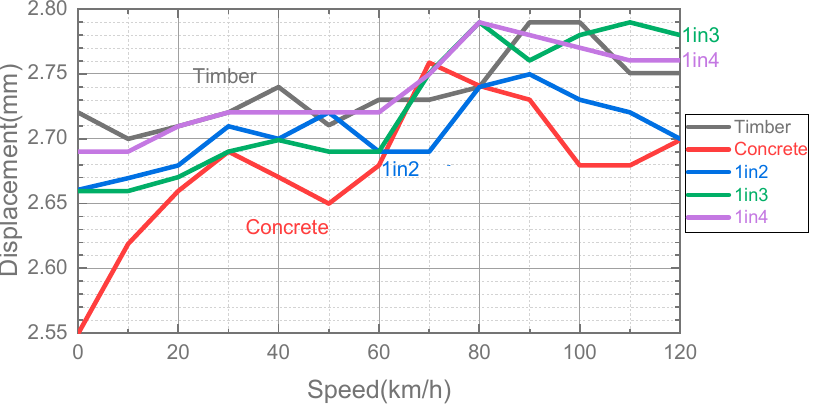
Figure 10. Maximum rail displacement of different fully supported tracks under different train speeds. To compare the vulnerability of 1in4 interspersed track and timber tracks under heavy rain (floods) and strong wind conditions, the maximum dynamic responses of these tracks exposed to large-scale loss of sleeper support at 60 km/h are presented in Figure 11. The half sleeper support condition and uneven axle loads are adopted to reflect the ballast washaway condition caused by heavy rain (flood) and the lateral wind condition. It can be seen from Figure 11 that the interspersed tracks have better track performance than timber tracks under the same load and track support conditions. The uneven group load will induce higher deformation in track sleepers. Besides, the moving loads and the poor track support state can result in unequal vertical rail displacement on two rails. The height difference between two rails is usually referred to as ‘cross level’. This elevation difference may result in train derailments. In order to keep the rail lines in proper operating condi- tion, short twists and long twists are often used to judge the rail elevation conditions. If either twist value exceeds the suggested value, certain track measures and repairs must be carried out to improve the track status.